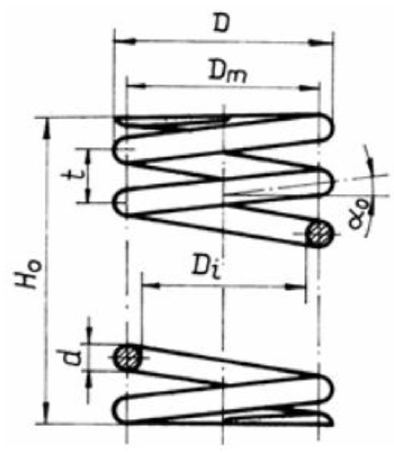
Figure 6. The spring of the valve. The elastic characteristic of the spring was determined using a spring test stand, Figure 7. The operation of the stand was based on the rotation of a crank through which a worm-driven gear was driven which caused the spring to act on a spring with a certain force corresponding to a weight whose value could be read on the graduated dial. Simultaneously, the value of the spring deformation corresponding to the applied weight could be read on the graduated ruler.